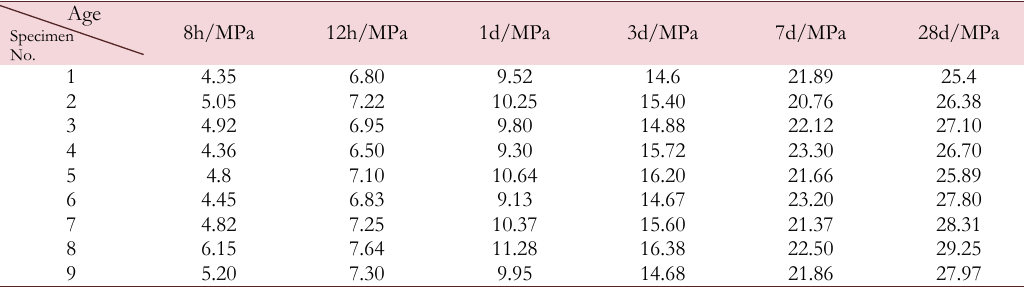
Table 3: Uniaxial compressive strength of shotcrete added with the traditional accelerator.